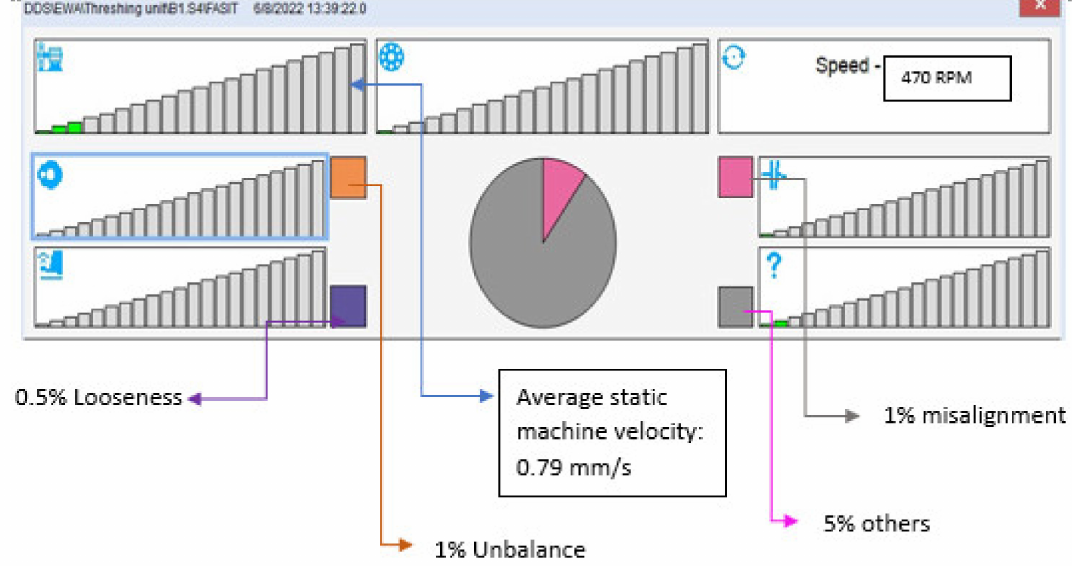
Figure 16. The Adash FASIT tool display for correctable mechanical conditions (looseness, misalignment, bearing, unbalance, and